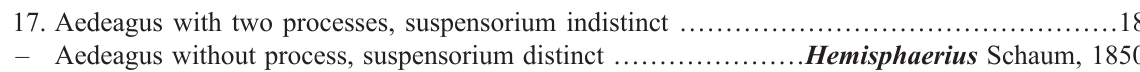
18. Pygofer in profile with hind margin distinctly angulated; phallobase asymmetrical at apex (Chan & Pygofer not distinctly angulated; phallobase symmetrical (Chan & Yang 1994: fig. 26) …………